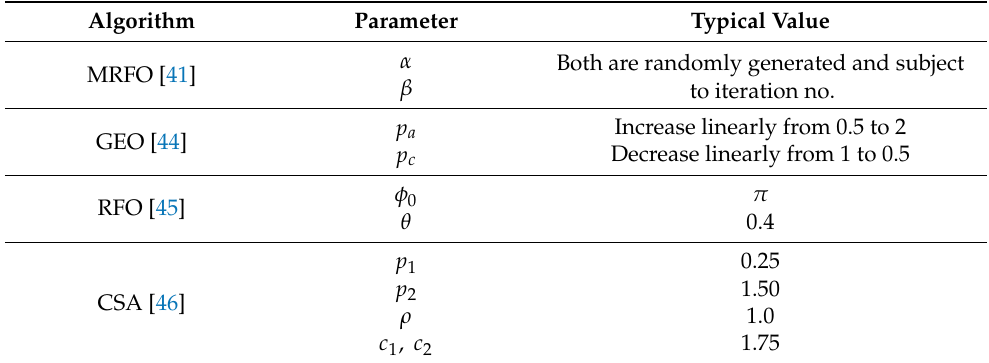
Table 2. Control parameter settings of the